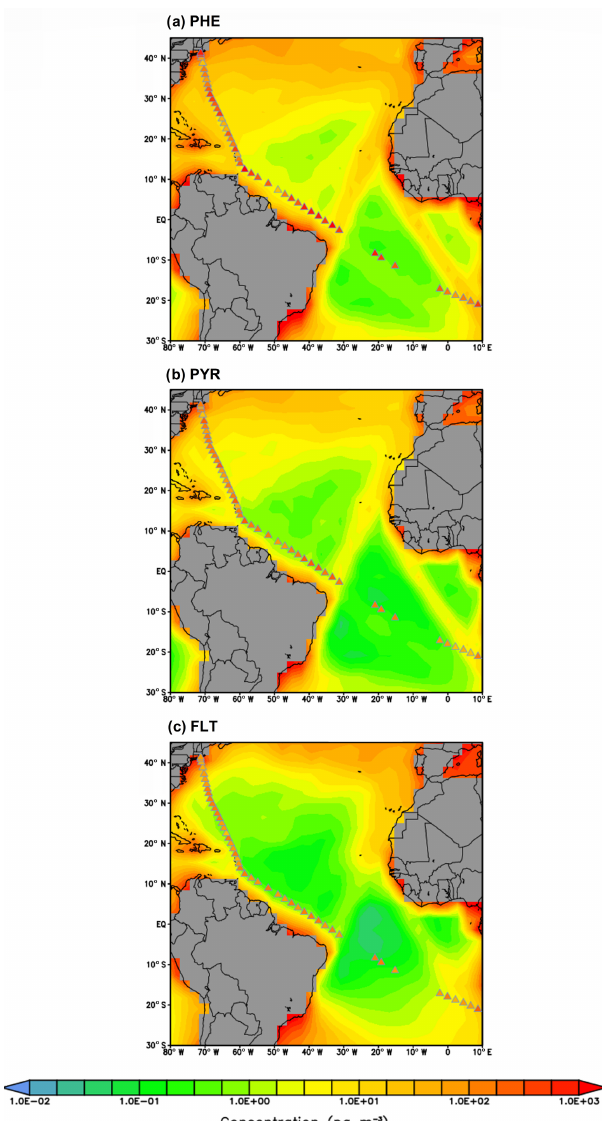
Figure 6. Simulated concentrations of PHE, PYR, and FLT (pgm − 3 ) over the Atlantic ocean overlaid with concentrations from a ship cruise measurement campaign during July 2009 (triangles). Land grid cells are depicted in gray